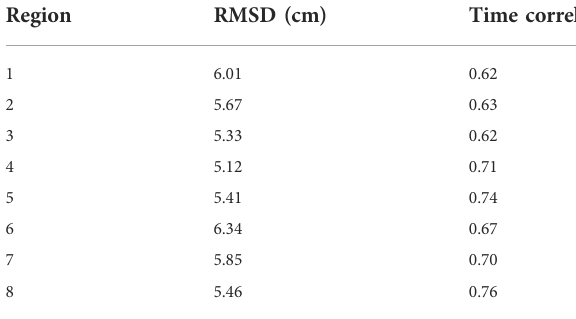
TABLE4RMSDbetweenthefreesurfaceofMITOandAVISOdata(SSH anomaly). Region RMSD